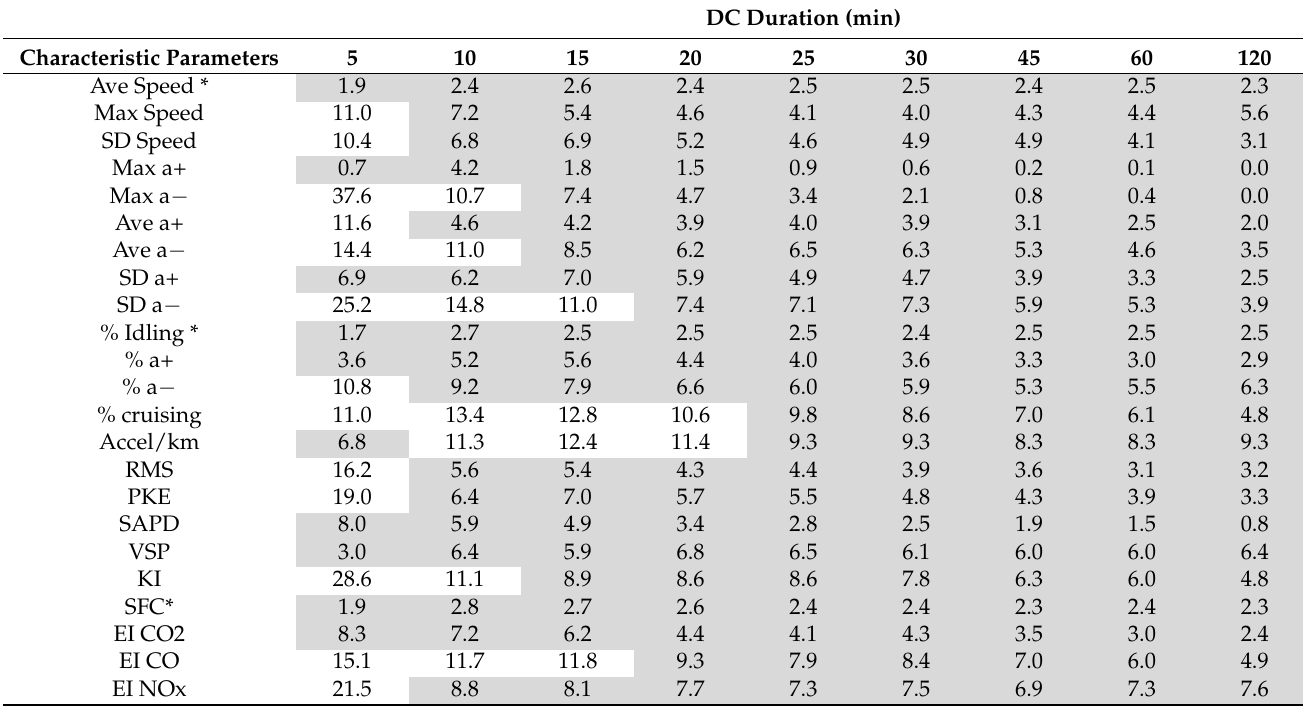
* Characteristic parameter used in the assessment criteria. Table 3. MRD i obtained for the 500 DCs obtained by the micro-trip method using the same trip database for the case of the Urban 2